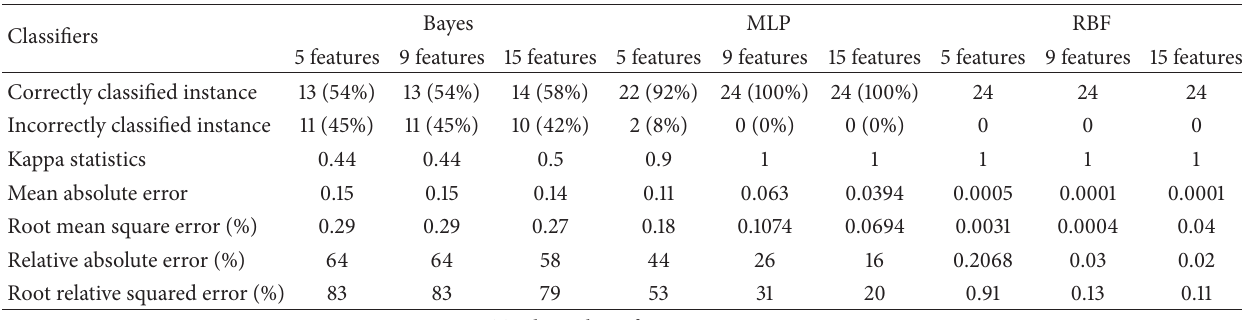
Table 7: Performance criteria of the classifiers.